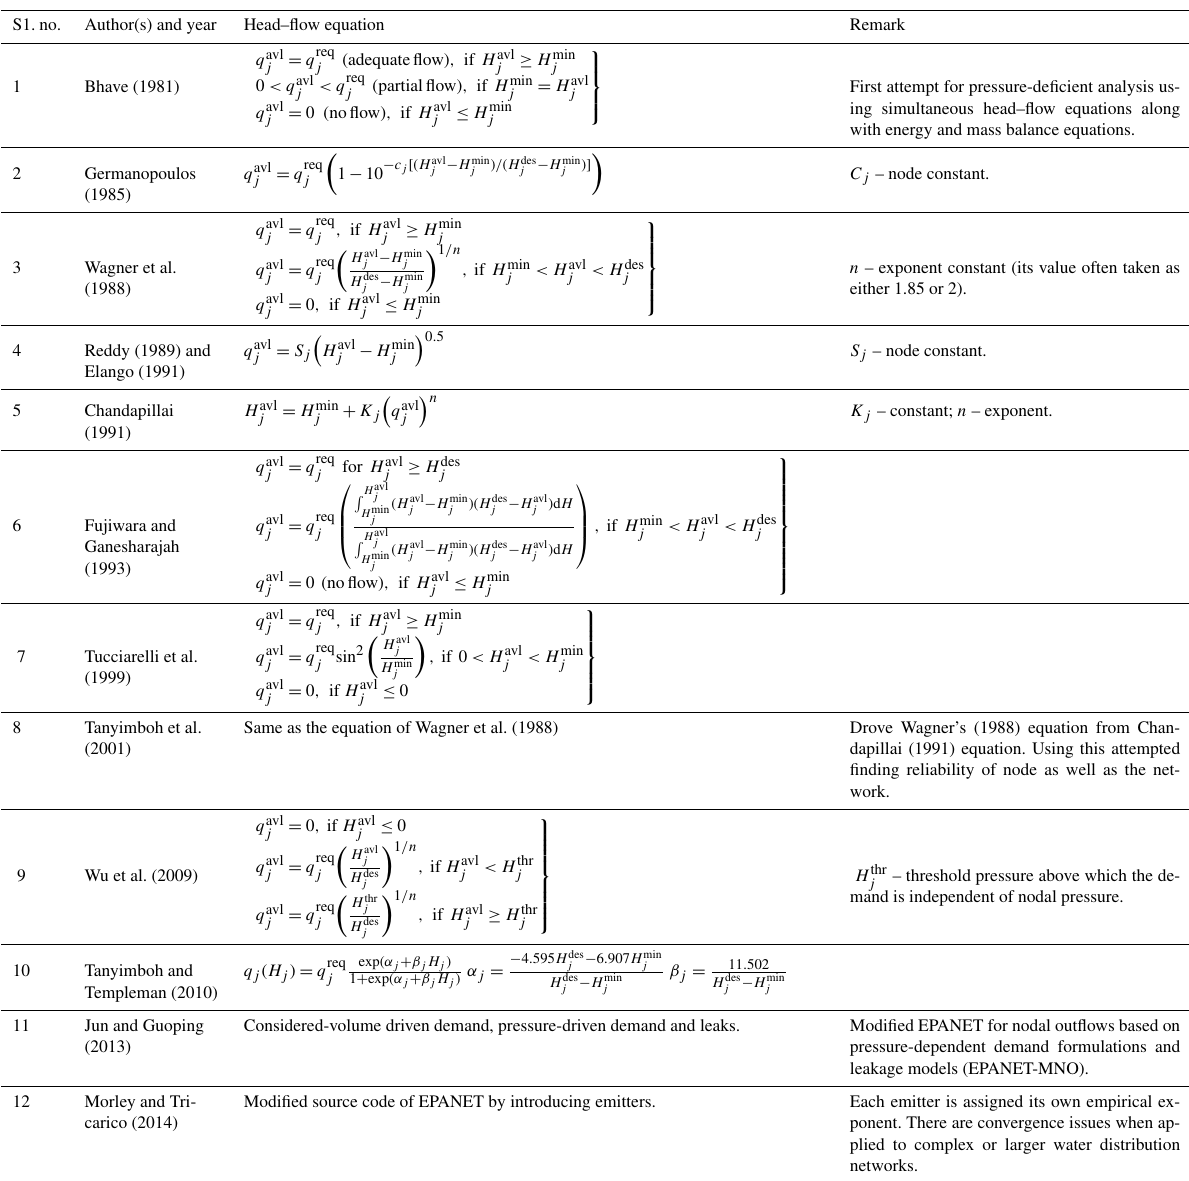
Table 1. Various head–flow relationships for